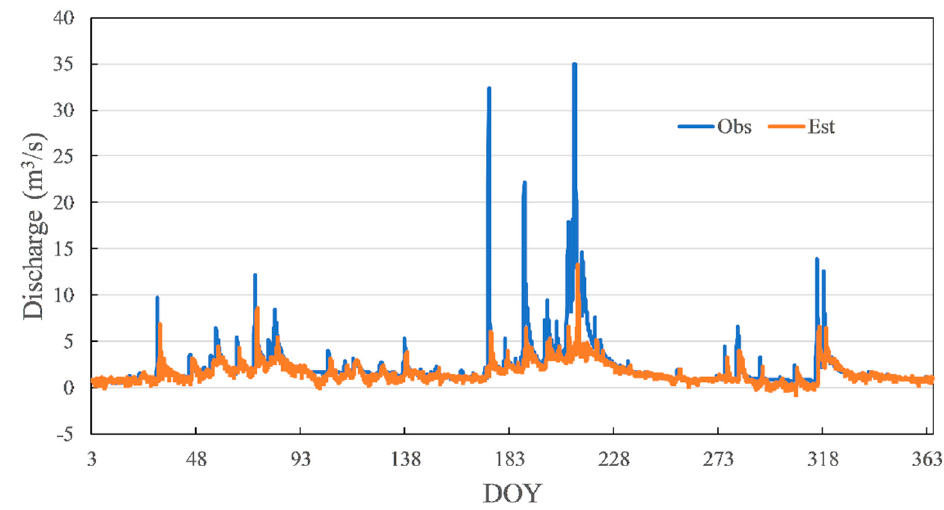
Figure 5. Relationship between RMSE, MAE, and NSE.